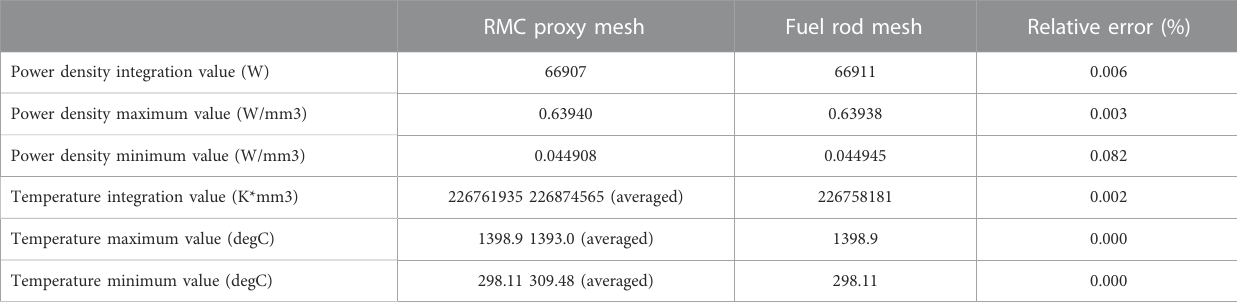
TABLE 1 Statistical values of variables on different meshes.